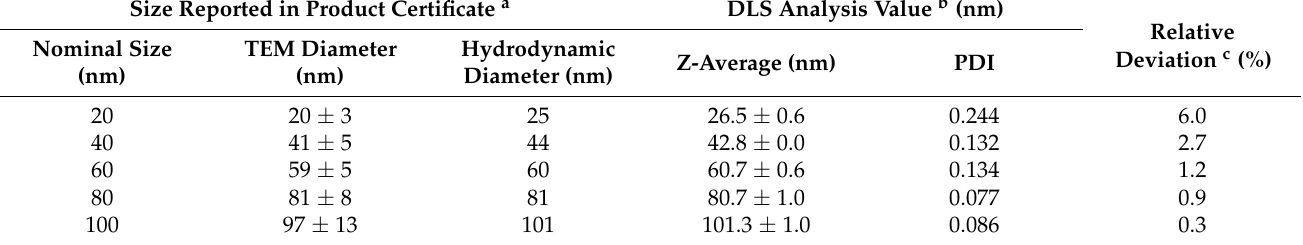
Table 1. Evaluation of the distribution of commercial AgNPs standard suspensions used for size calibration.